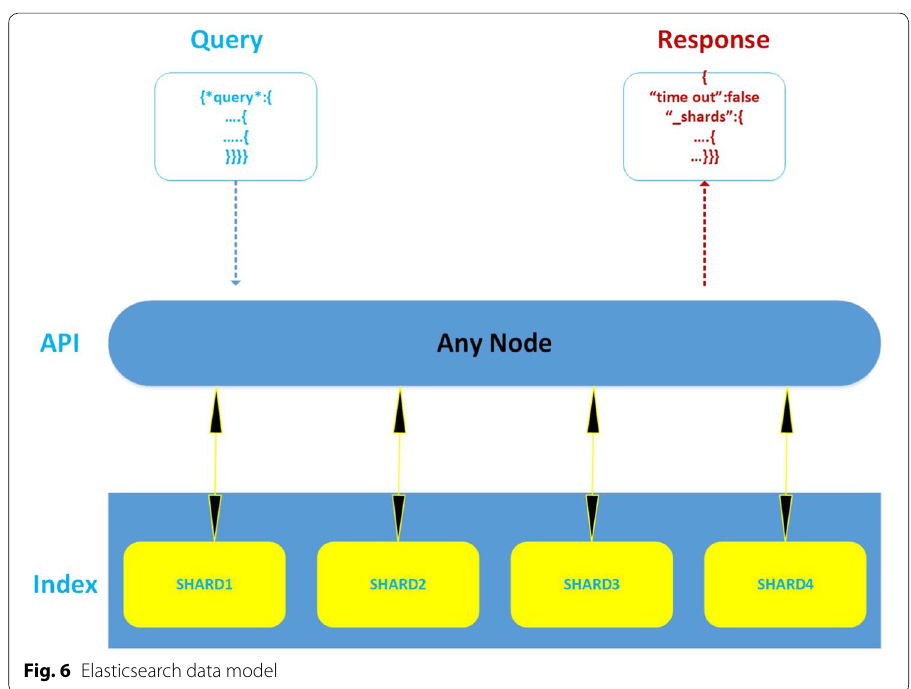
Fig. 6 Elasticsearch data model